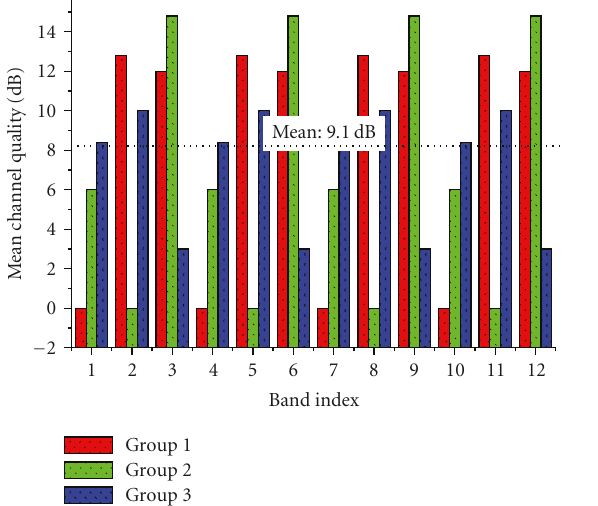
Figure 7: Average system throughput performance as varying the number of bands available( L = 1, M = μ )